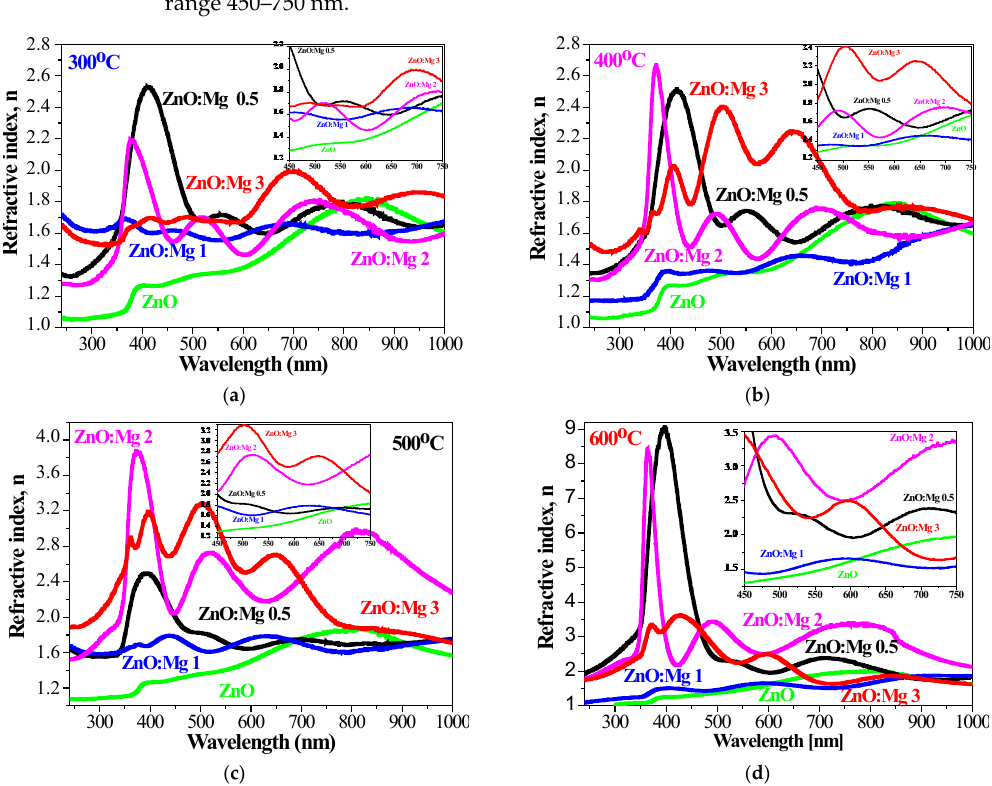
Figure 14. Refractive index n of the sol–gel films of ZnO and ZnO:Mg, treated at ( a ) 300 °C, ( b ) 400 °C, ( c ) 500 °C and ( d ) 600 °C. The inset figures show n values in the spectral range 450–750 nm. A similar increase in the refractive index with doping with different elements is re- ported for sol–gel boron-doped ZnO films [82] and for Fe, Co, Mn, Ni doped ZnO films deposited by spray pyrolysis [81]. The refractive index values are also dependent on the experimental optical measurement technique used (spectrophotometry or spectroscopic ellipsometry) and the approaches used for extraction of the refractive index from these measurements [78]. Table 1 presents a small part of the reference data for n values of ZnO materials, prepared by different methods [6,78,79,81–91]. It can be seen that the refractive index values vary in a very broad range. Mg doping also results in an increase in the re- fractive index of ZnO, as it has been determined that the doping concentration and the annealing temperatures significantly affect the n values. The optical study of the sol–gel ZnO films reveals that their optical properties are affected by Mg doping. For a certain dopant content, the transparency of the films is im- proved. The optical band gap can be tuned by varying the Mg concentration in the sol solution. The refractive index is changed with doping and annealing.